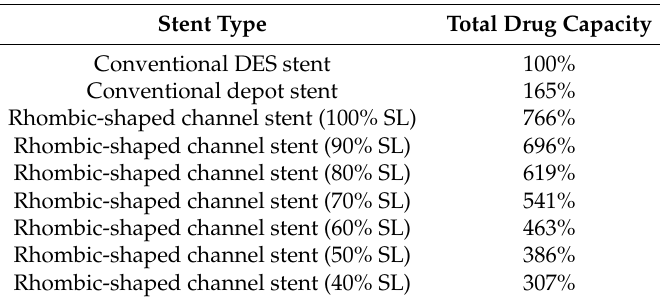
Table 1. Comparison of total drug